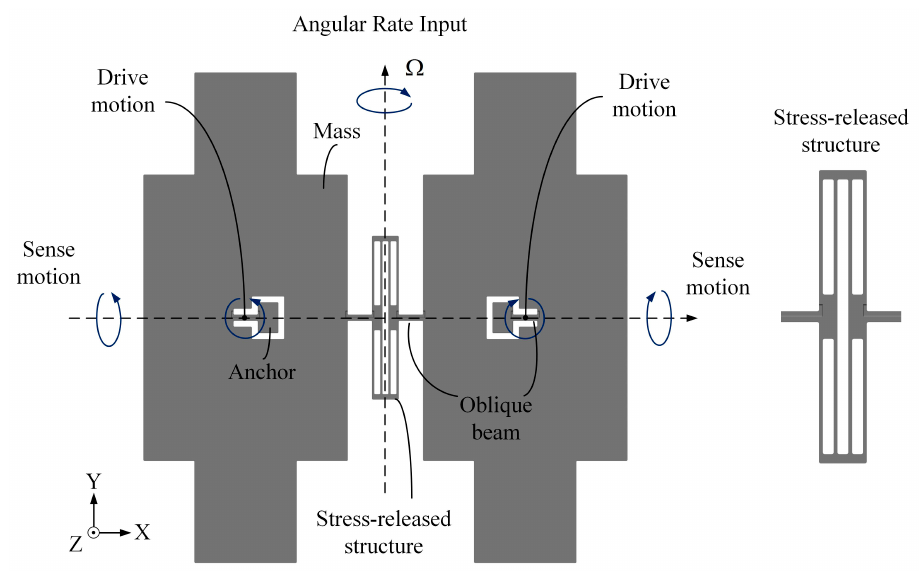
Figure 1. Sensing structure of the Butterfly vibratory gyroscope (BFVG).